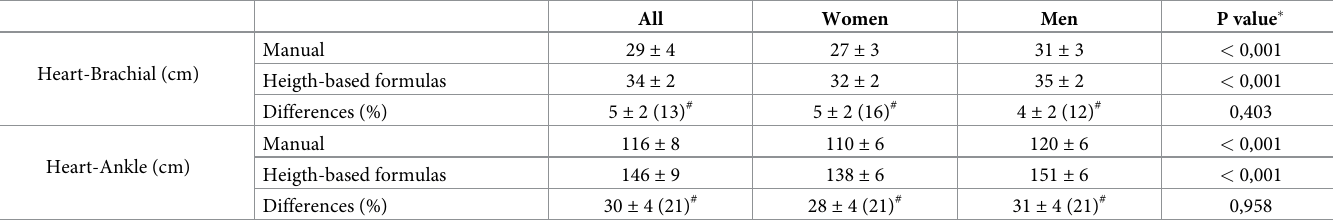
Table 2. Differences between arterial path length and abD-PWV with manual measurement compared against height-based formulas.